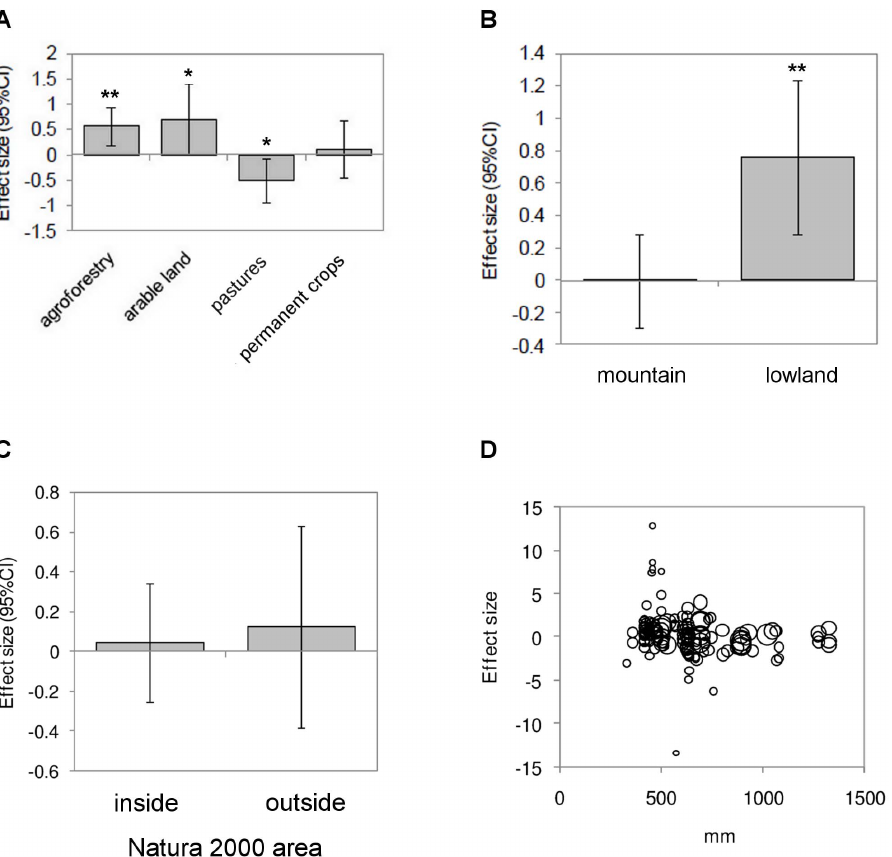
Figure 5. Effect size (95% CI) of land abandonment for (A) previous land use; (B) landform; (C) protected areas; (D) precipitation. Q- test shows significant different effect sizes (heterogeneity) between groups (A: Q=18.72, P=0.009 and B: Q=9.76, P=0.0076), but not for C: (Q=0.31, P=0.8553). D displays a bubble plot of the relationship between effect size and precipitation, with the size of the bubbles scaled according to the reciprocal of the standard deviation of the effect size.